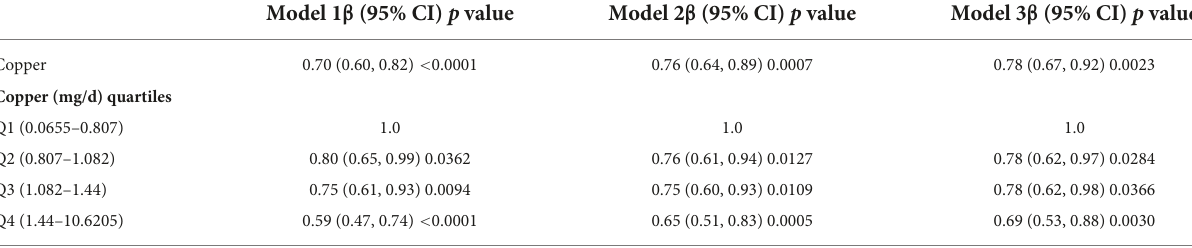
TABLE 4 Correlation analysis between copper intake and myocardial infarction before matching.